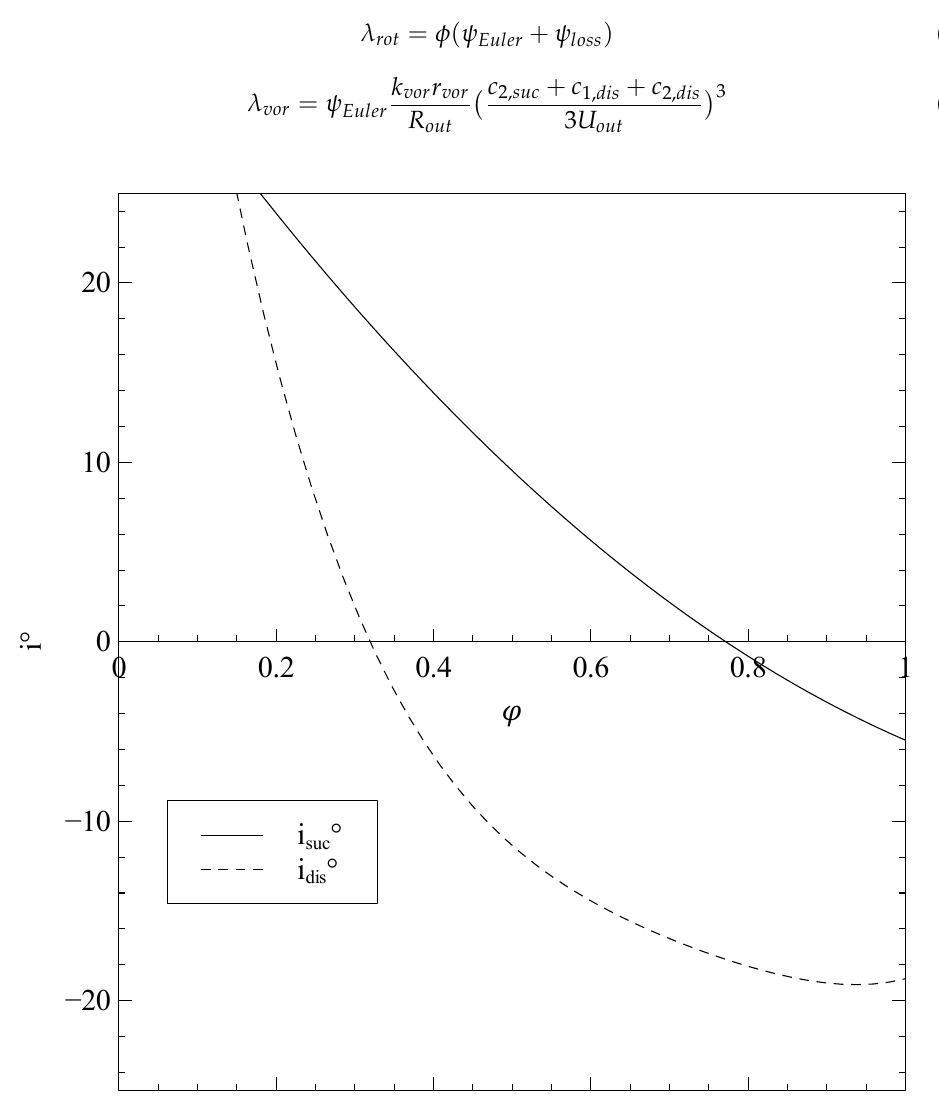
Figure 16. Incidence angles in the two